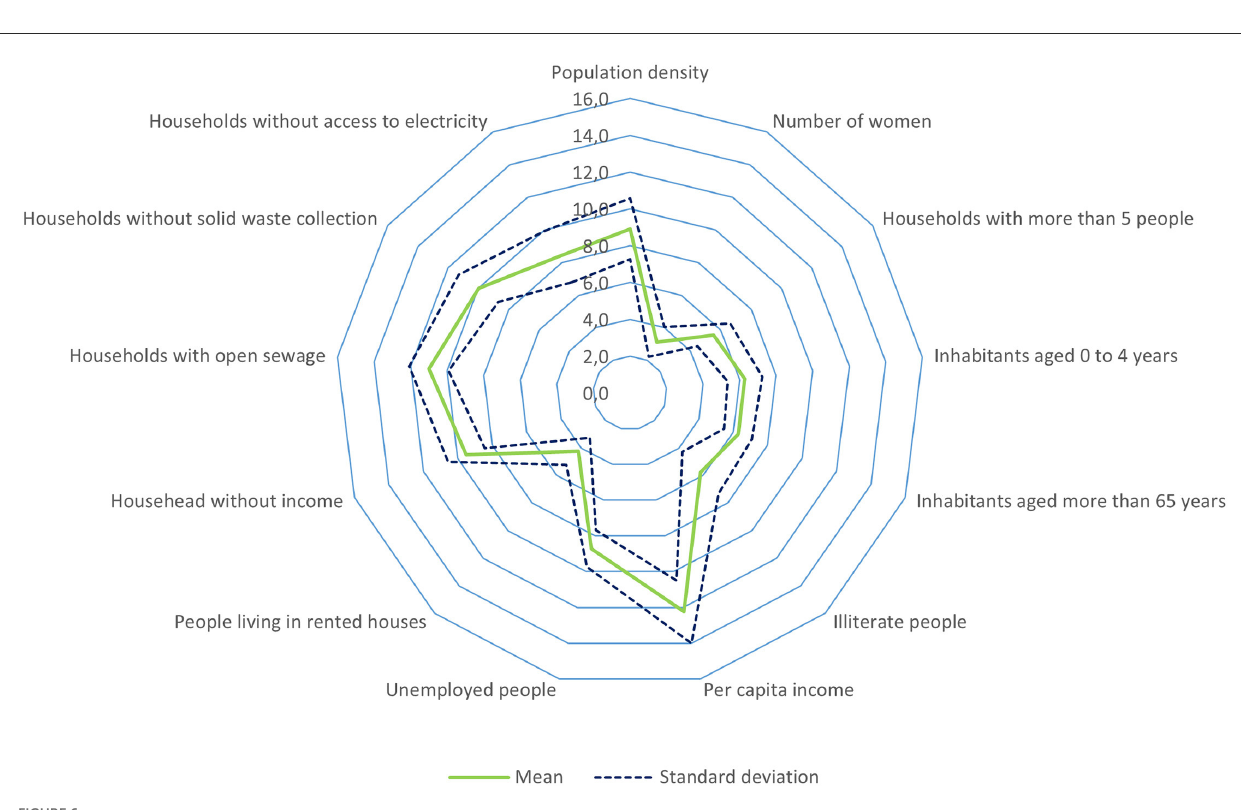
FIGURE6 Radar chart illustrating how the mean and standard deviation of the indicator’s global weights